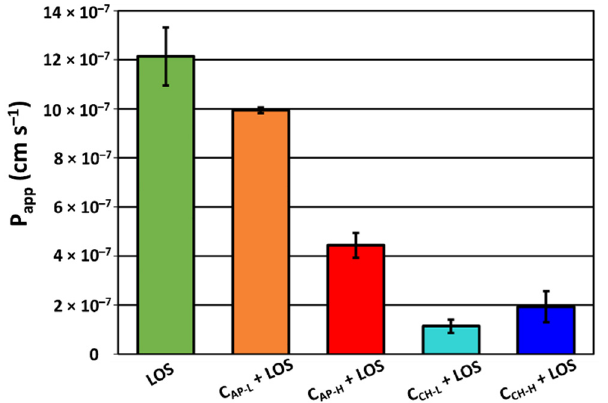
Figure 10. Gastrointestinal mean permeability of intrinsic losartan potassium and after liberation from functionalized ordered mesoporous carbons.